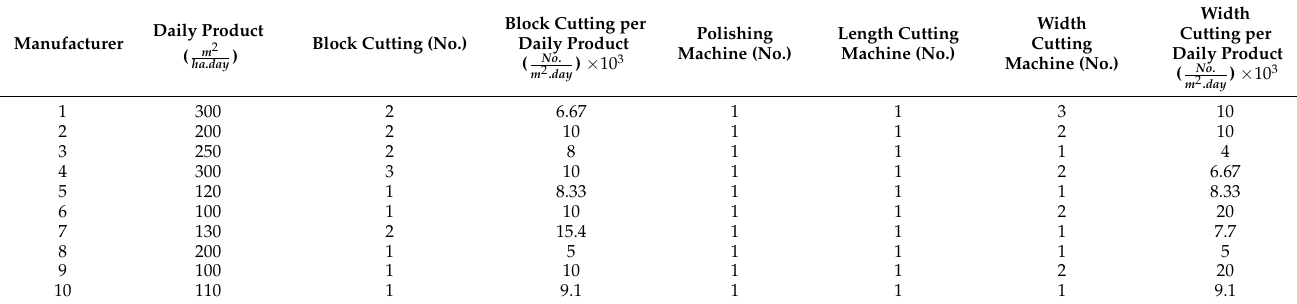
Table 3. Stonecutting machines number based on data from 10 Iranian stonecutting factories.